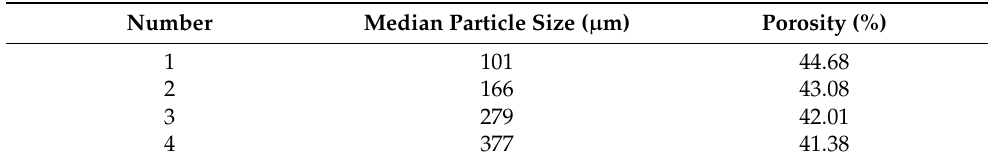
Table 1. Properties of natural river sand .